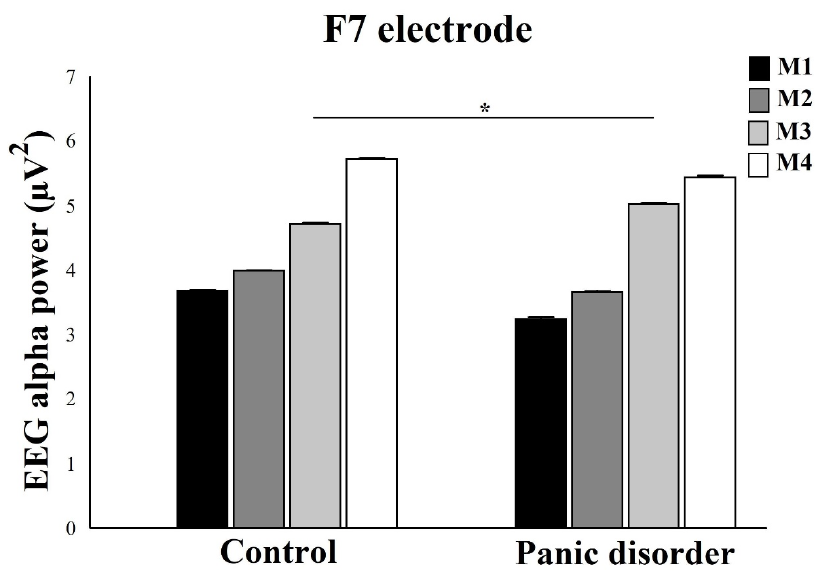
Figure 6. In relation to F7 electrode, the analysis shows an increase in the EEG alpha power in the experimental group when compared to control for M3 moment. The interaction between group and moment for the left ventrolateral prefrontal cortex is demonstrated by mean ± standard error, and statistically significant difference is indicated with *, p ≤ 0.0125. For the electrodes of the right hemisphere, the results suggested a main effect for Group for the electrodes Fp2 (F(2) = 6.03; p = 0.002; ƞ 2 p = 0.48; power = 97%) (Figure 7), F4 (F(2) = 7.35; p = 0.001; ƞ 2 p = 0.51; power = 99%) (Figure 8), and F8 (F(2) = 4.41; p = 0.001; ƞ 2 p = 0.46; power = 95%) (Figure 9). In general, there was a decrease in the EEG alpha power in the experimental group.